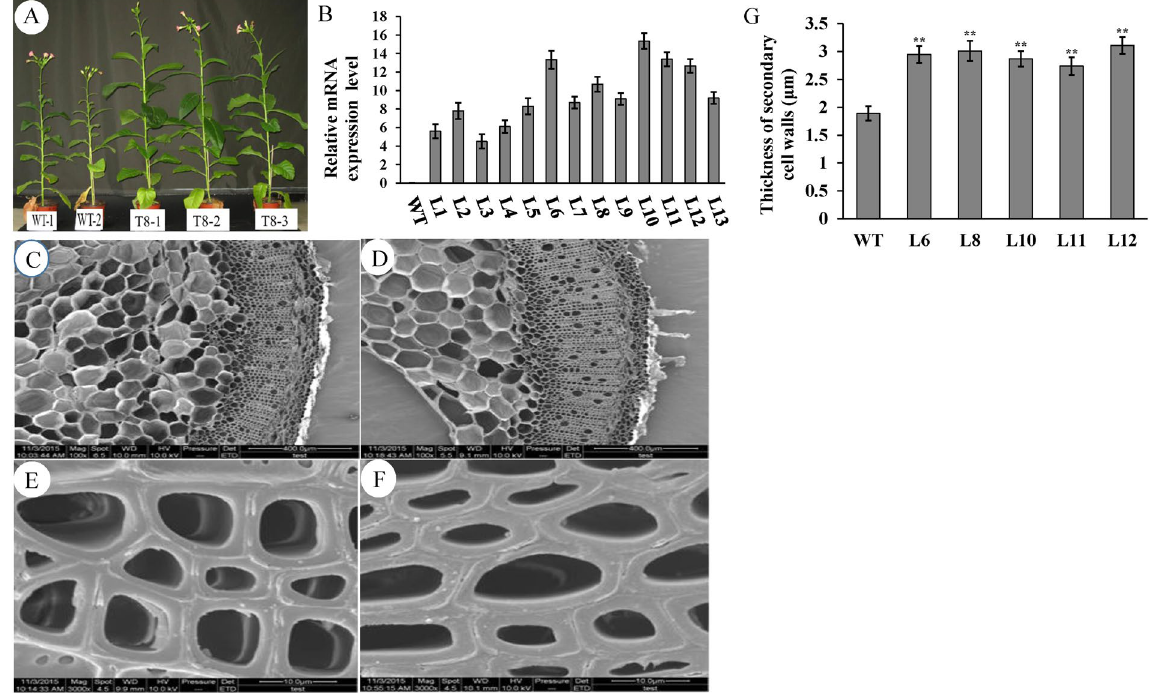
Figure 4. Effect of PsnSHN2 overexpression on the secondary wall thickness in the stems of PsnSHN2 transgenic lines. ( A ) Three-month-old wild-type (left) and PsnSHN2 transgenic lines (middle and right). ( B ) The expression levels of PsnSHN2 in transgenic lines. Error bars represent SD of three biological replicates. ( C–F ) The scanning electron microscope of cross stem sections of wild-type ( C,E ) and PsnSHN2 transgenic lines ( D,F ). ( G ) The secondary wall thickness of cross stem sections of PsnSHN2 transgenic lines. Error bars represent SD of three biological replicates. Asterisks indicate levels of significance ( t test; * P < 0.05, ** P < 0.01).